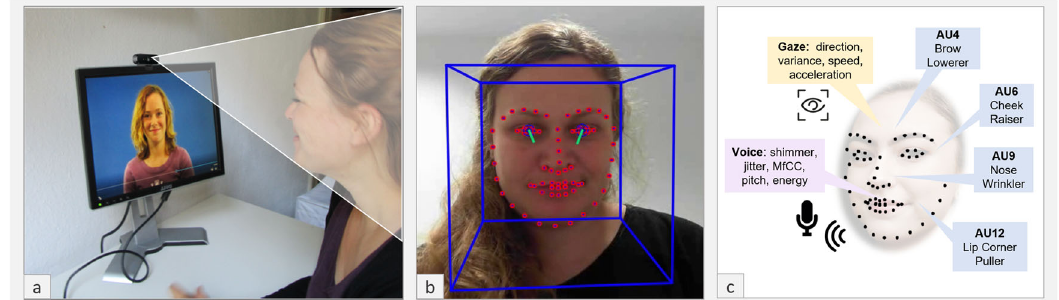
Fig. 6 Experimental setting und automated analysis of SIT. a Neurotypical participant taking the SIT. b Face-tracking and gaze-tracking using OpenFace. c Facial landmarks and features of main interest; written informed consent was obtained from the persons to have their photos used in this